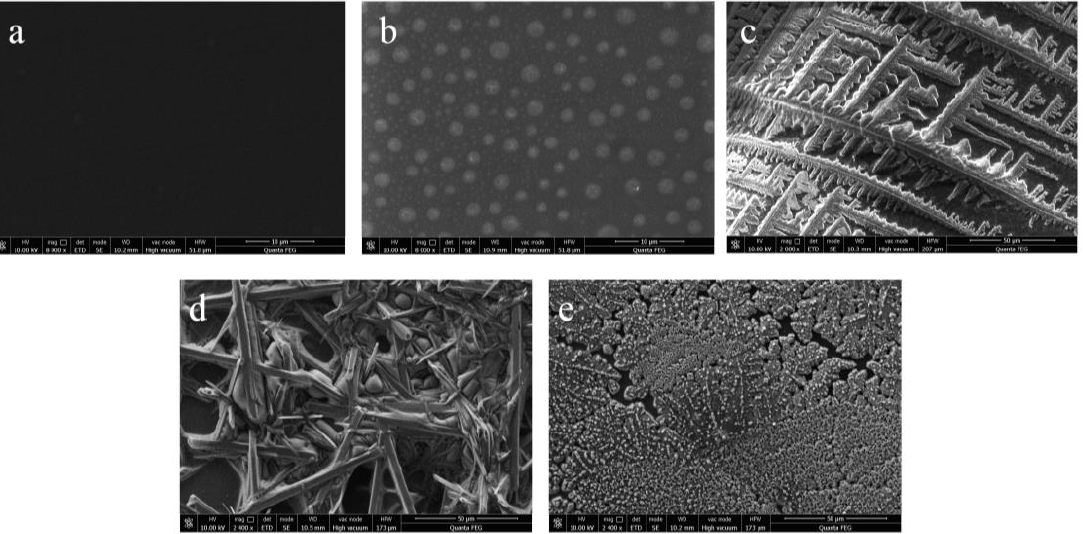
Figure 3. SEM of sensor assembly process: ( a ) GCE; ( b ) Thi-Chit/GCE; ( c ) AuNPs-HRP/Thi- Chit/GCE; ( d ) spike protein/AuNPs-HRP/Thi-Chit/GCE; ( e ) BSA/spike protein/AuNPs-HRP/Thi- Chit/GCE.